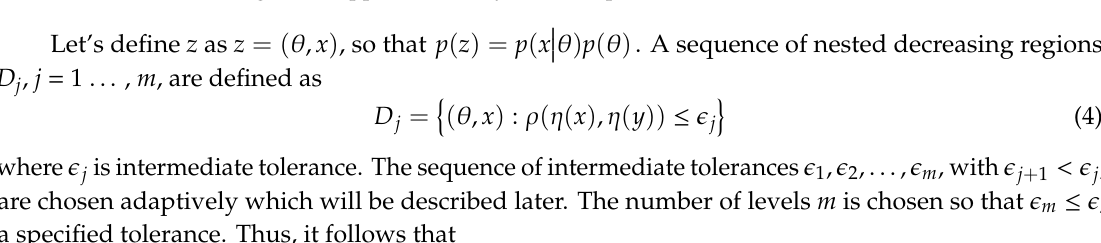
Figure 1. Schematic diagram of approximate Bayesian computation with subset simulation (ABC-SubSim).